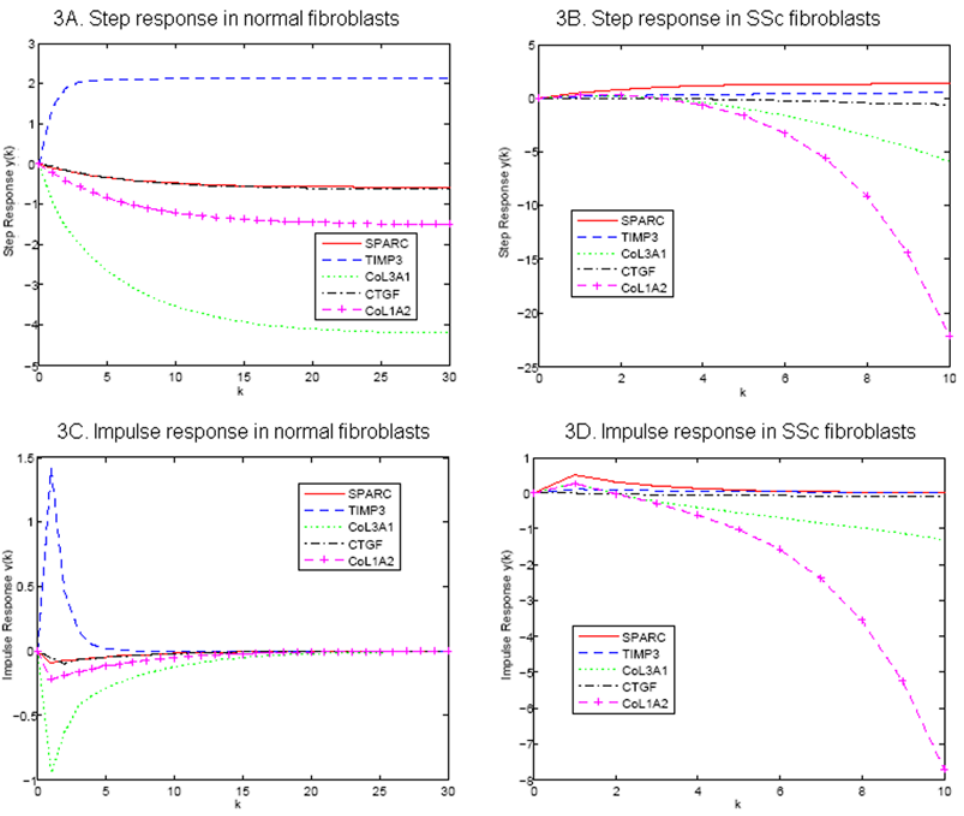
Figure 3. Step response and impulse response of the genes to perturbation of silica in cultured fibroblasts.